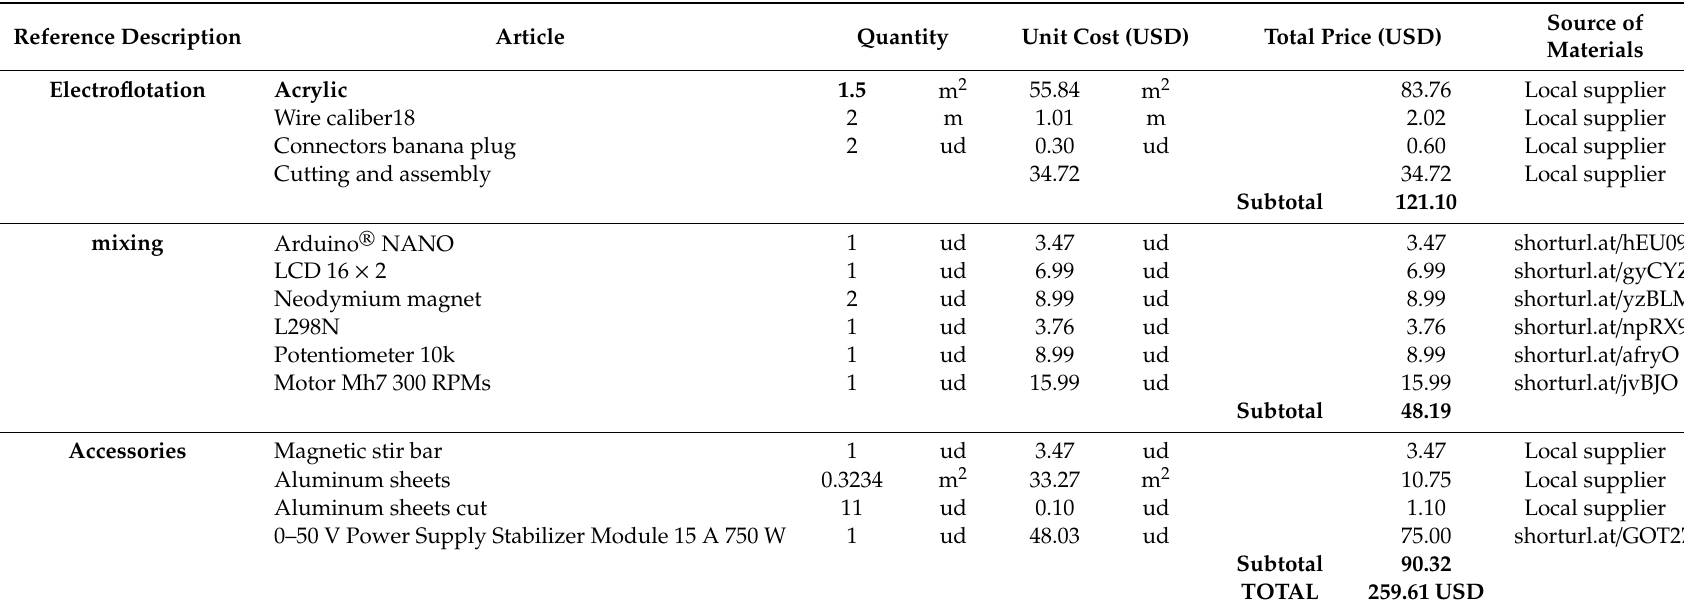
Table A1. Cost and Source of Materials for the Construction of the